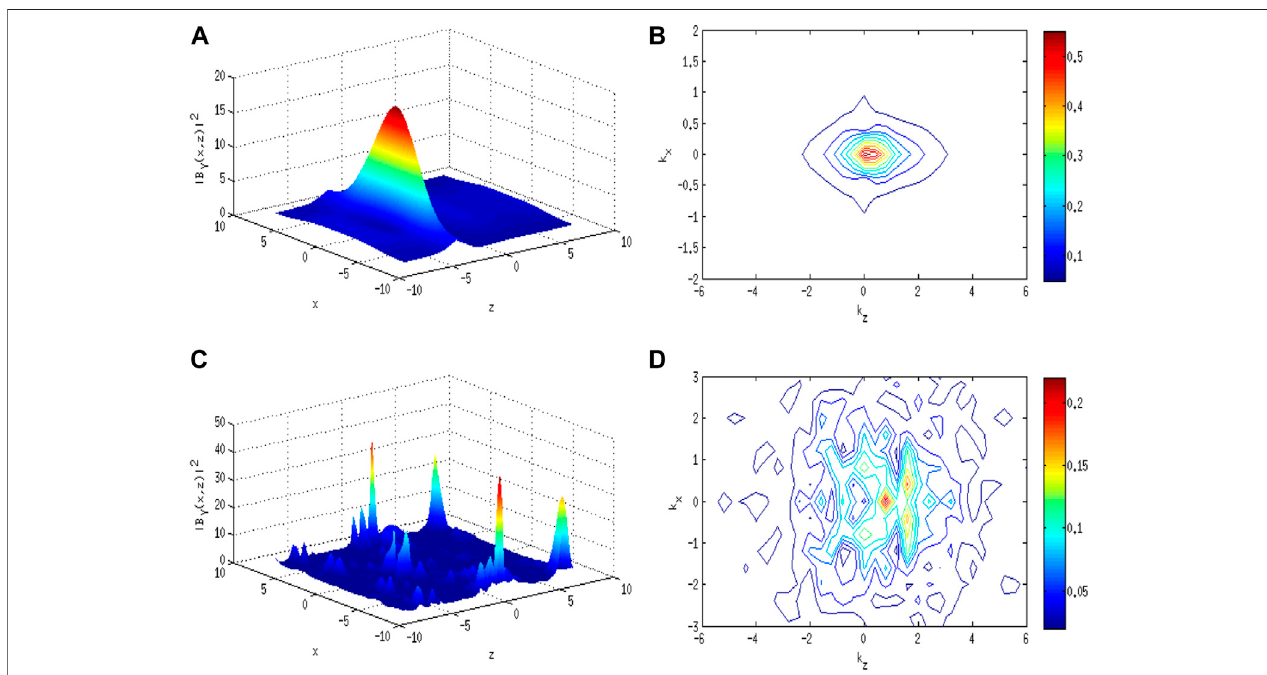
FIGURE 1 | With IC-1. (A) Normalized intensity pro fi le of the KAW magnetic fi eld ( | B 2 y | / B 2 n ) at normalized t = 6 (t normalized by t n (cid:2) ( 2 ω / V 2 A k 2 0 z ) ) in a normalized x – z plane( x normalizedwith x n (cid:2) ρ s ,and z normalizedby z n (cid:2) 2/ k 0 z ). (B) Contoursofnormalized | B yk | 2 againstFouriermodesofKAWatt=6. (C) Normalizedintensitypro fi le of the KAW magnetic fi eld (| B 2 y | / B 2 n ) at normalized t = 13. (D) Contours of normalized | B yk | 2 against Fourier modes of KAW at t = 13. “ Reproduced from [(Gaur and Sharma, 2014), Astrophys Space Sci (2014) 350 , https://doi.org/10.1007/s10509-013-17701], with the permission of Springer Publishing.